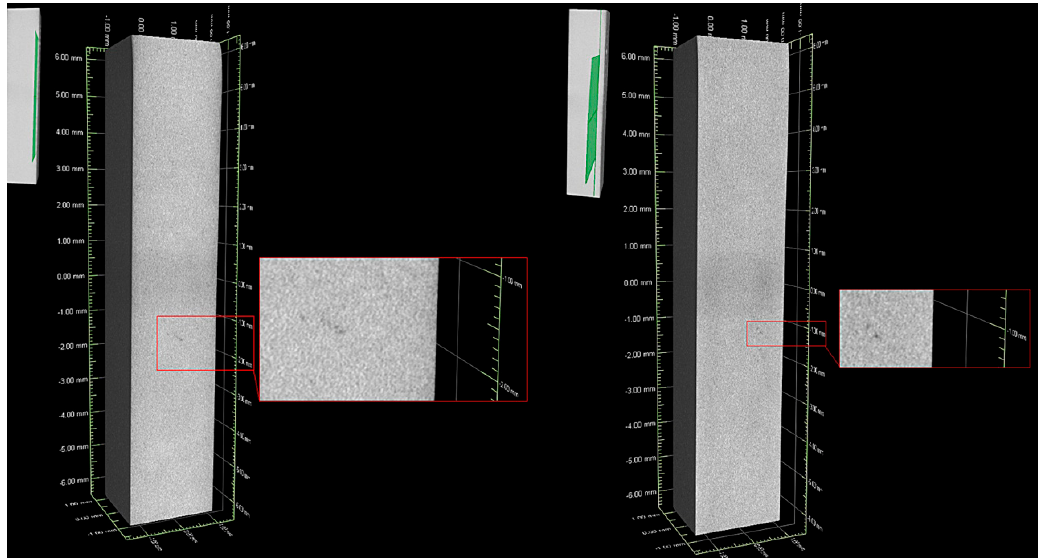
Figure 3. Computed tomography images of the remelted Inconel 740 used for the chemical composition modification. Table 2. The modification of Inconel 740 (wt%).